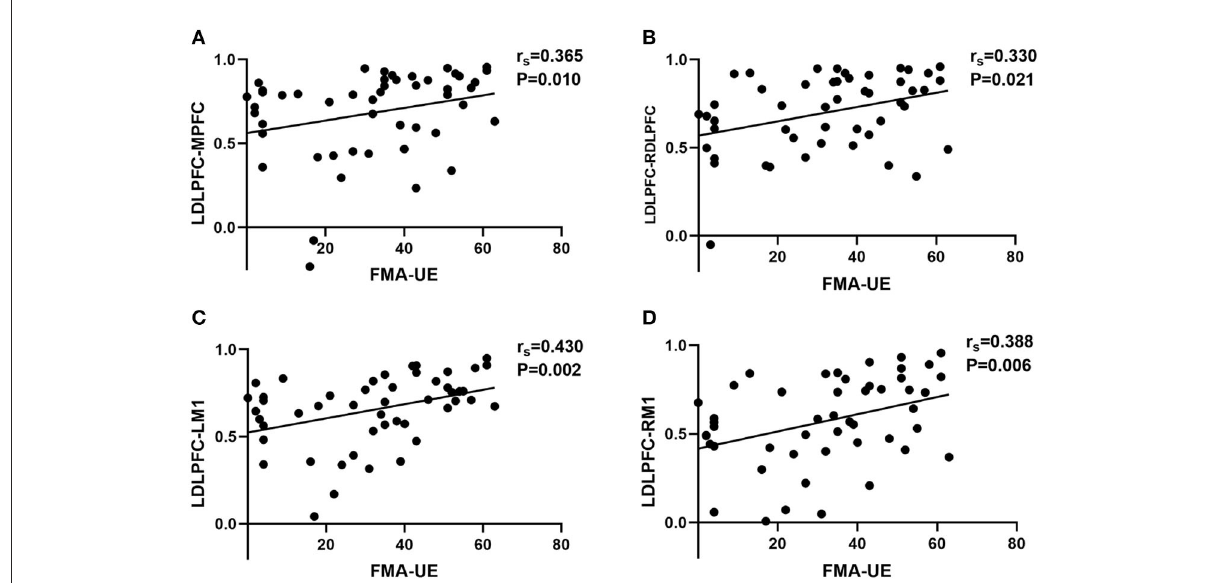
FIGURE4 The correlation scatter diagrams of Spearman’s correlation analysis between FMA-UE scores and RSFC among different ROIs. LDLPFC, left dorsolateral prefrontal cortex; MPFC, middle prefrontal cortex; RDLPFC, right dorsolateral prefrontal cortex; LM1, left primary motor cortex; RM1, right primary motor cortex. We defined left hemisphere is ipsilesional hemisphere and right hemisphere is contralesional hemisphere. (A) The significant correlation between FMA-UE and FC of LDLPFC–MPFC. (B) The significant correlation between FMA-UE and FC of LDLPFC–RDLPFC. (C) The significant correlation between FMA-UE and FC of LDLPFC–LM1. (D) The significant correlation between FMA-UE and FC of LDLPFC–RM1. The “rs” is the correlation coefficient of Spearman’s